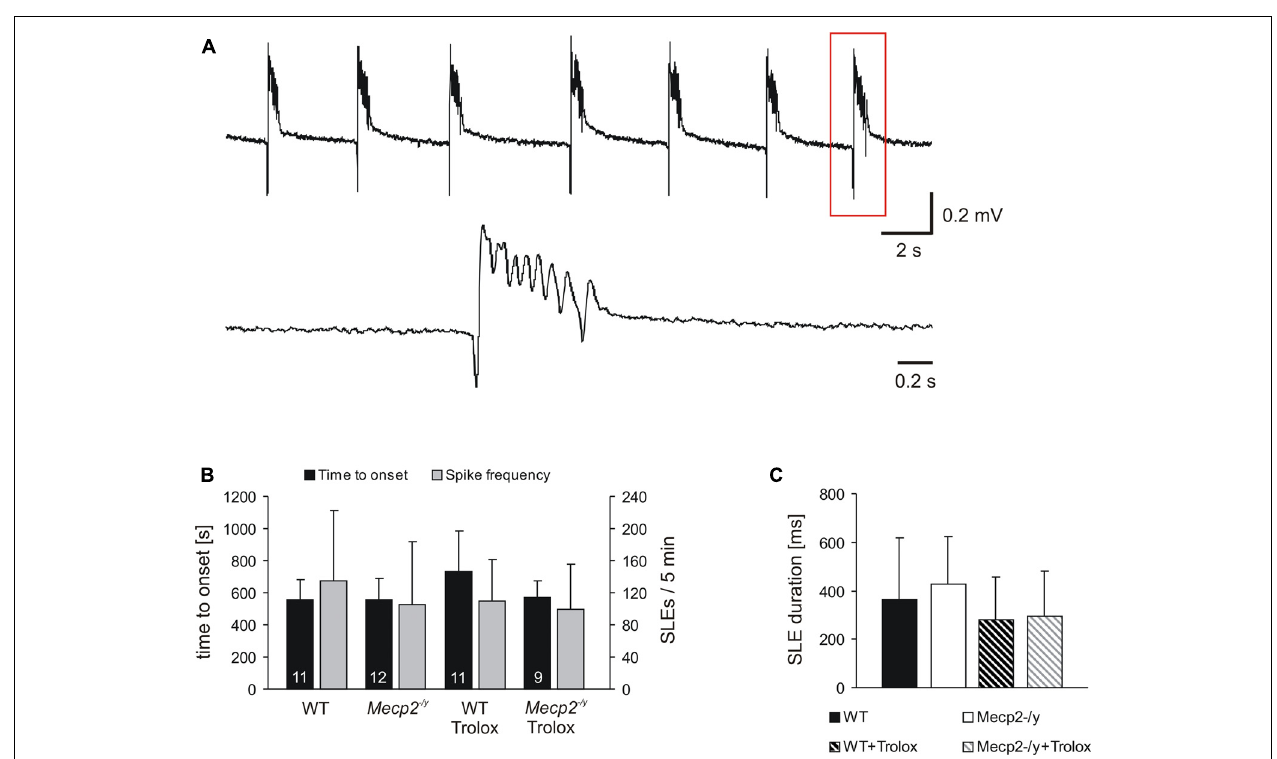
postpone the onset of discharges as compared to untreated slices.The number of slices analyzed is indicated and applies to panel C as well. (C) Statistically significant differences in the duration of the individual SLEs among the genotypes were not observed.Trolox only tended to somewhat reduce the duration of the individual discharges inWT and Mecp2 − / y